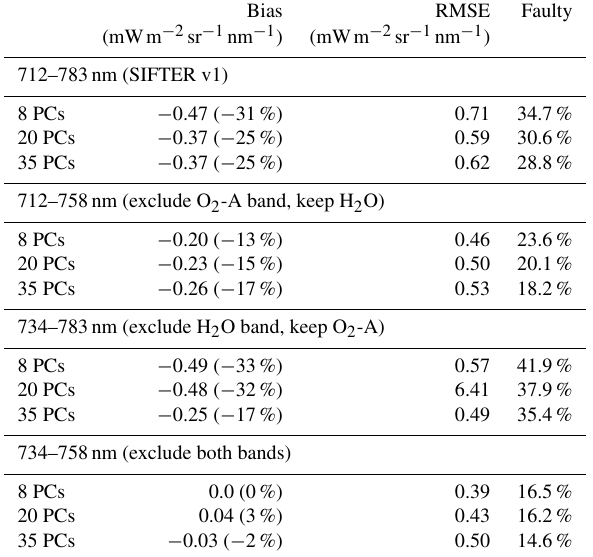
Table 2. Results of the “fluorescence” experiment (mean of 1000 spectra) to reproduce fluorescence for different fitting windows and number of PCs used. The bias is defined here as the mean of the dif- ferences between assumed and retrieved fluorescence strength (on average 1.5mWm − 2 sr − 1 nm − 1 ), and the RMSE stands for the root of the mean of the squared deviations. Faulty retrievals were not included in the calculation of the bias or the RMSE. “Faulty” re- trievals are characterised by high spectral autocorrelation ( > 0 . 2) in their fit residuals. All experiments were done without clouds, and the signal-to-noise ratio of the simulated reflectance spectra was